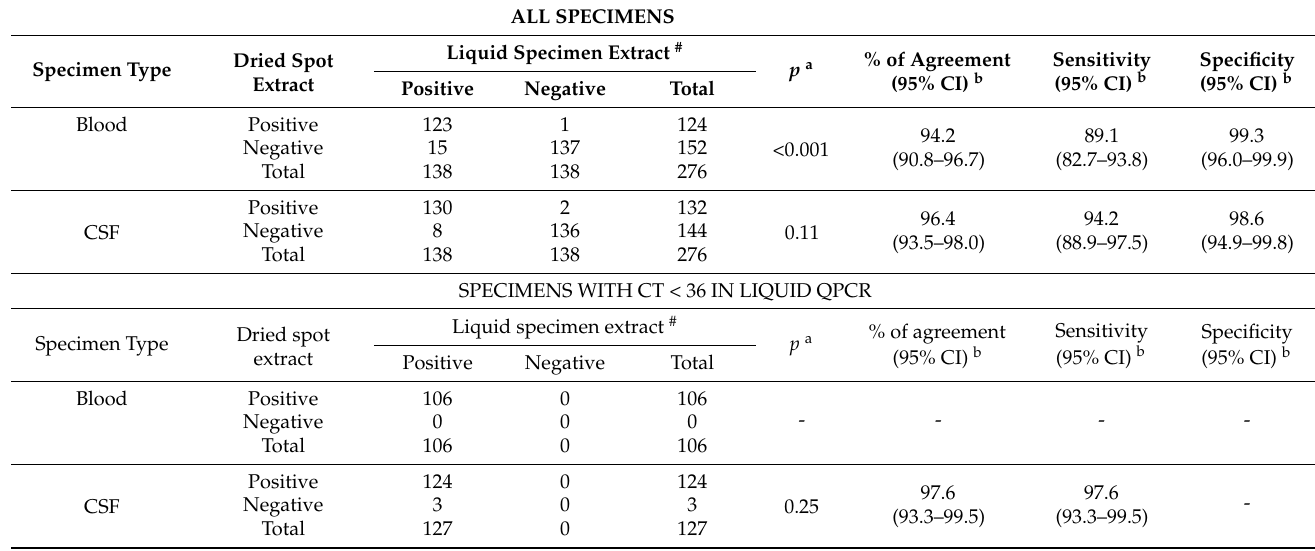
Table 1. Sensitivity and specificity of dried spot assay for blood and CSF specimens. ALL